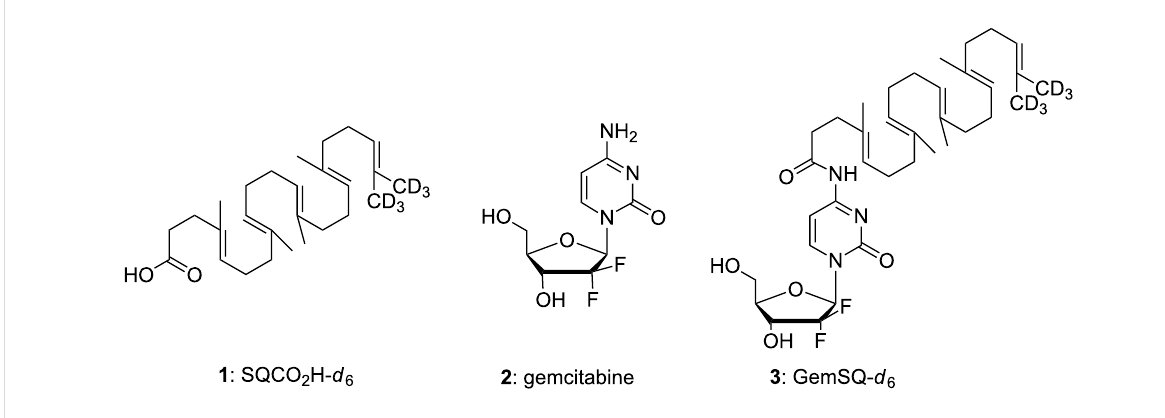
Figure 1: Structure of squalenic acid- d 6 , gemcitabine and GemSQ- d 6 conjugate.